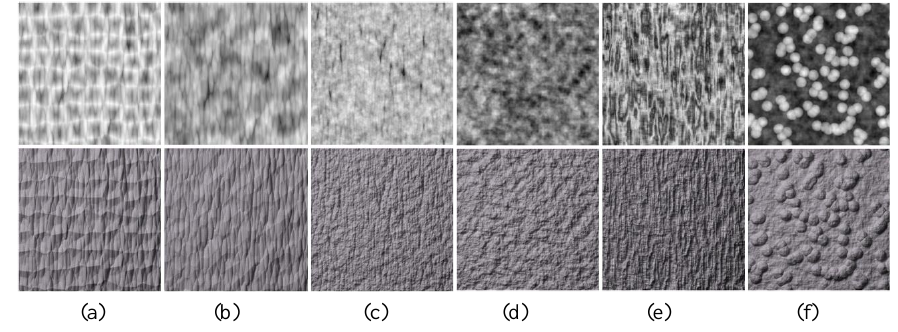
Figure 15. Textures generated with combination methods: ( a – c ) are textures generated with a combination of textons and cellular; and ( d – f ) are textures generated with combination of textons and Perlin noise. First, row: height maps; Second row: relighting